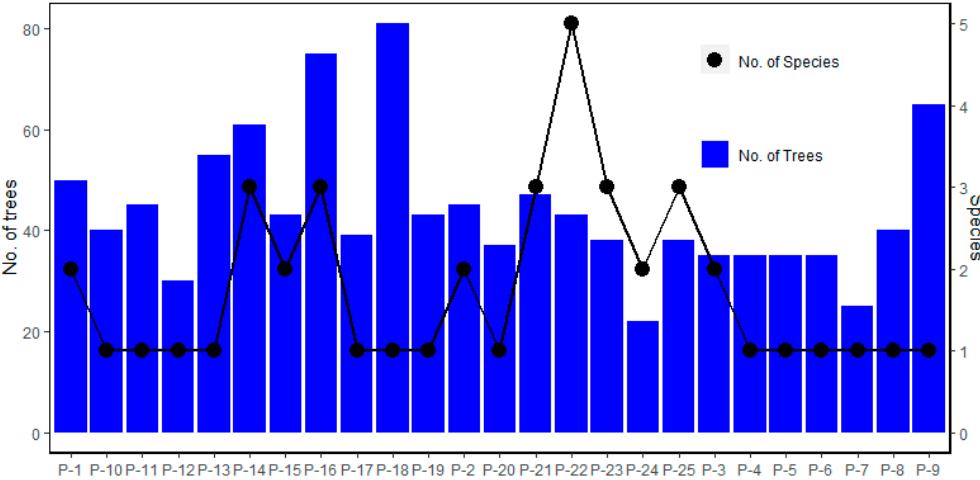
Figure 3. Tree abundance and number of species found in different plots in the mangrove stand of LetKhutKon Village.